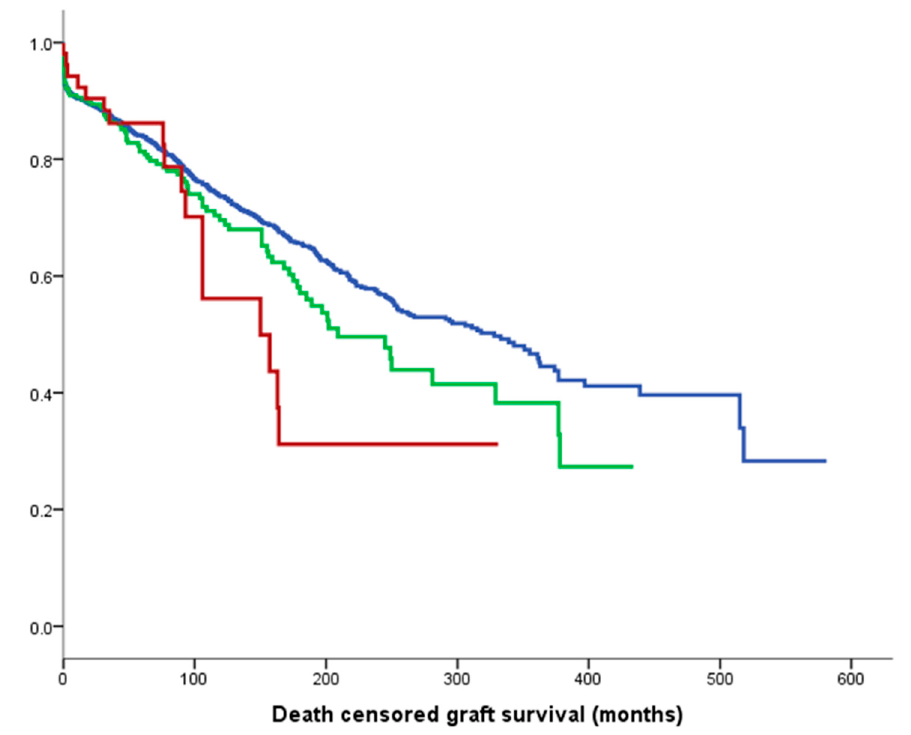
Figure 1. Median death-censored graft survival: 328 months for 1st graft (blue line), 209 months for 2nd (green line) and 150 months for 3rd+ (red line). ( p = 0.04). Death-censored graft survival remained significantly di ff erent between the three groups in the case of deceased donor transplants (Figure 2a), but there was no significant di ff erence in death-censored graft survival between the groups in living donor transplantation (Figure 2b).